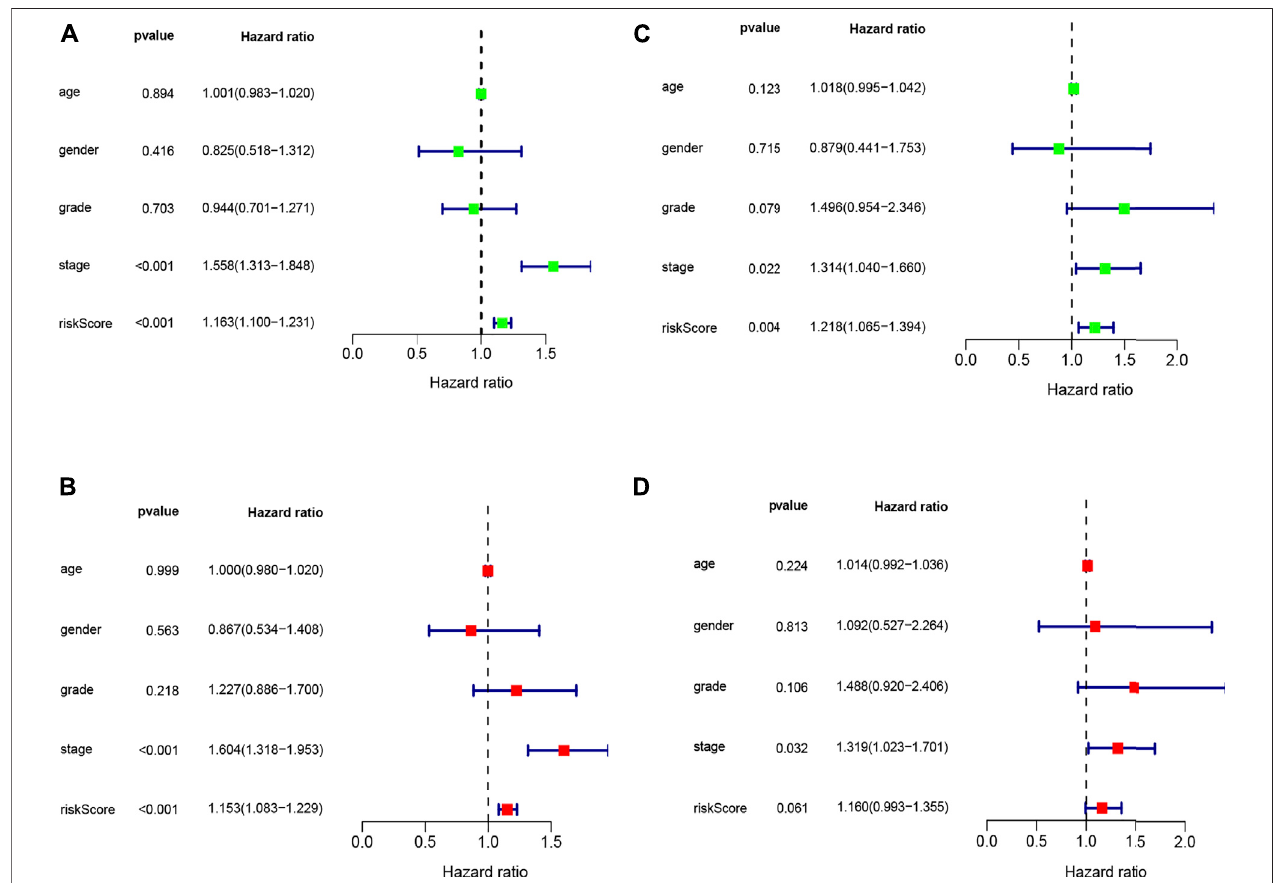
FIGURE 4 | Univariate (A,C) and multivariate (B,D) COX analysis for risk score and clinical variables in train and test sets.